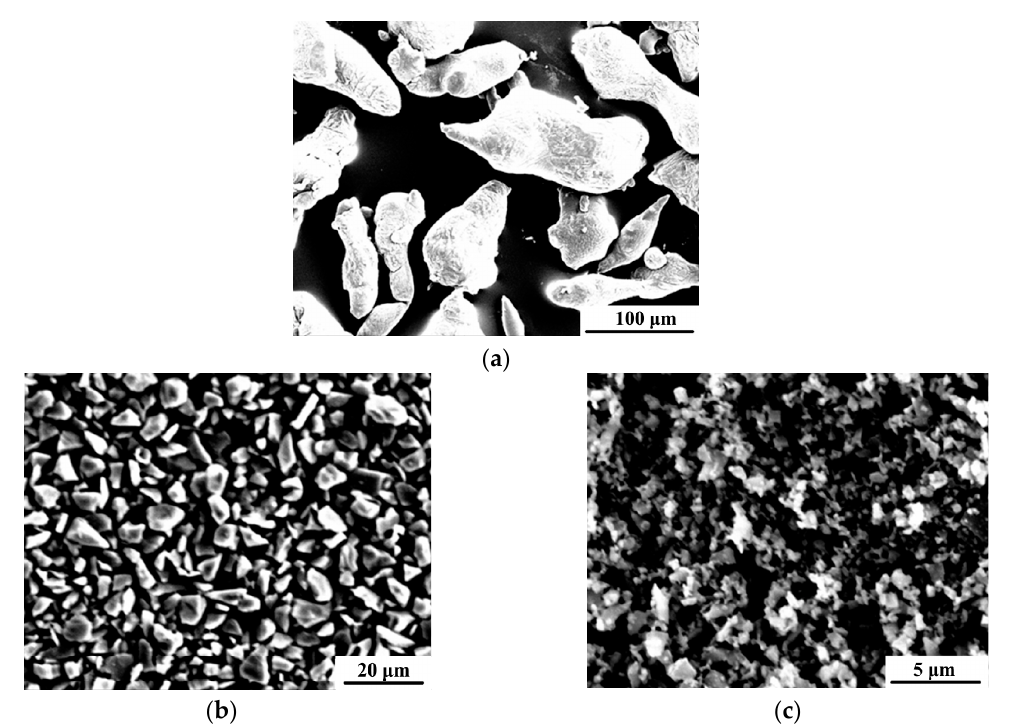
Figure 1. SEM of the raw powders: ( a ) Al, ( b ) Si, ( c ) SiC p .